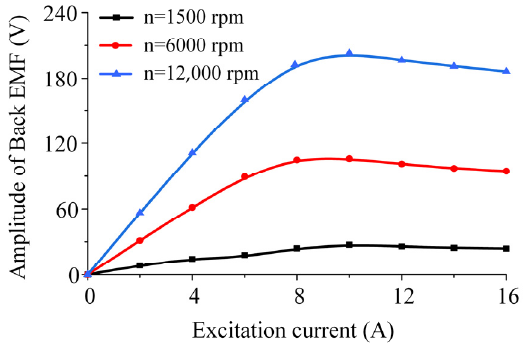
Figure 13. Curves of no-load